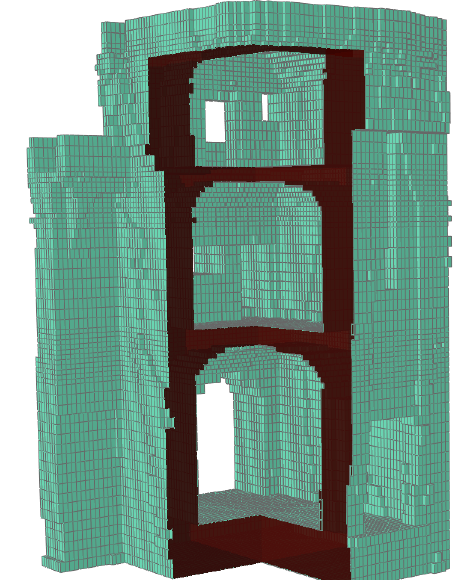
Figure 8. Voxel model: a section cut shows the different floors and their